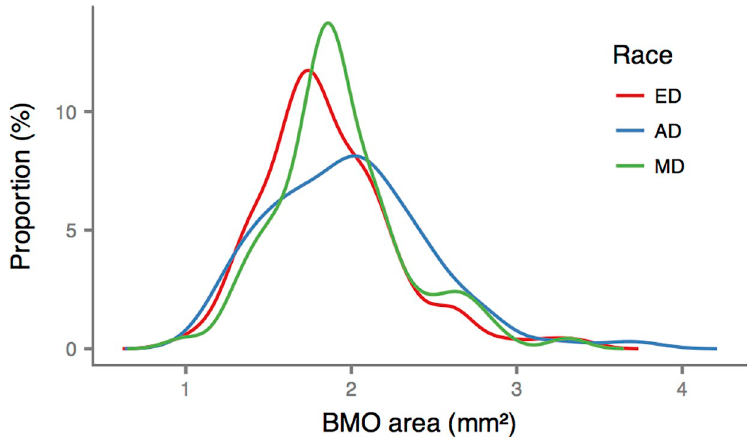
Fig 2. Smoothed histogram showing the distribution of Bruch’s membrane opening (BMO) areas for each race. ED: European Descent; AD: African Descent; MD: Mixed Descent.